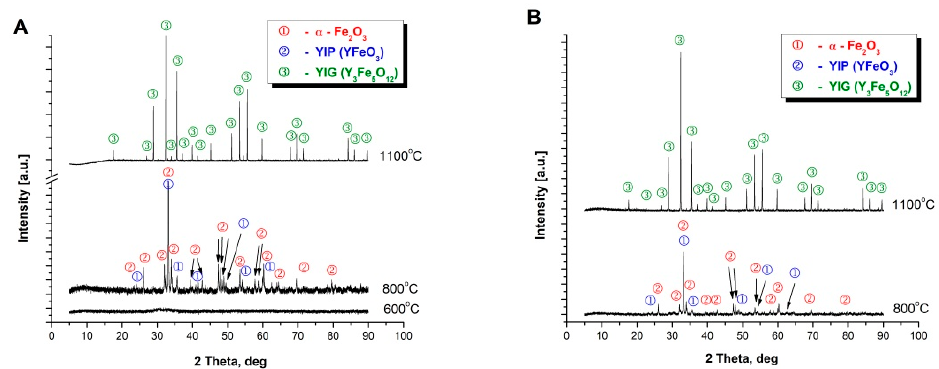
Figure 1. DSC curves of precursor powders obtained from: ( A )—Method A; ( B )—Method B; ( C )— Method C; ( D )—Method D.